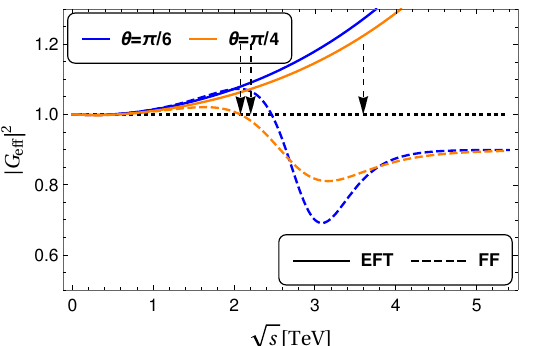
Figure 3 . j G e(cid:11) j 2 . The parameters are: M = 9 f , M D = 5 f , f = 0 : 6 TeV, (cid:20) g = 2 and (cid:21) = 3 ( s L = 0 : 091 and s R = 0 : 313). The two arrows correspond from left to right to (cid:3) c and m (cid:26) = 6 f .